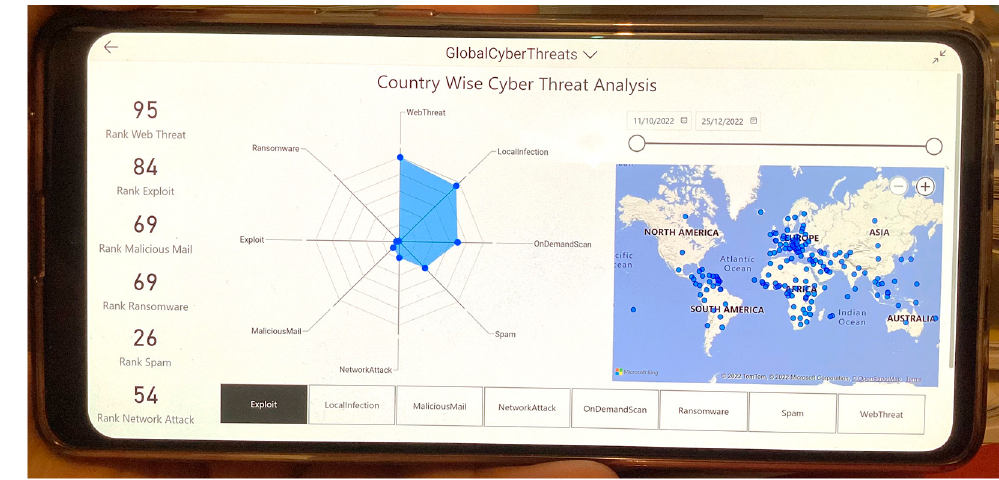
Figure 7. Global cyber ‐ attack data of different types are demonstrated on a deployed Android app on a Samsung Galaxy Note 10 Lite Mobile.